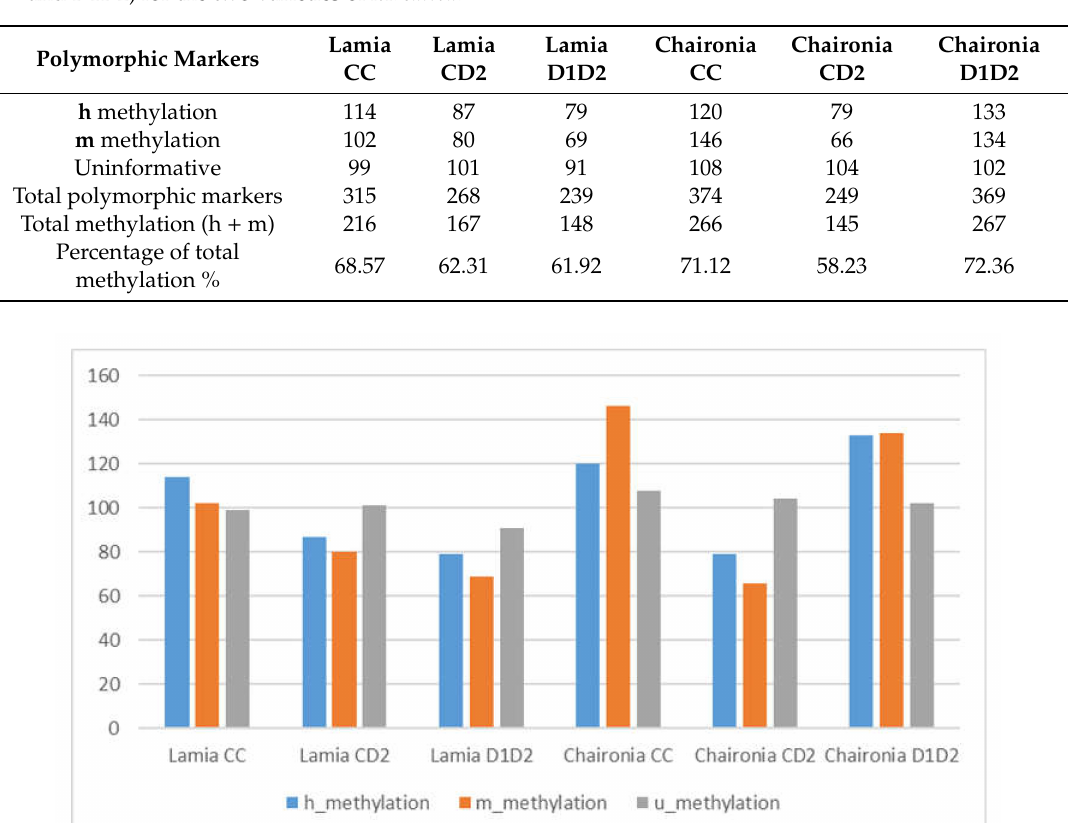
Table 3. DNA methylation polymorphic markers in control (CC) and the two drought treatments (CD2 and D1D2) for the two varieties of M. sativa.